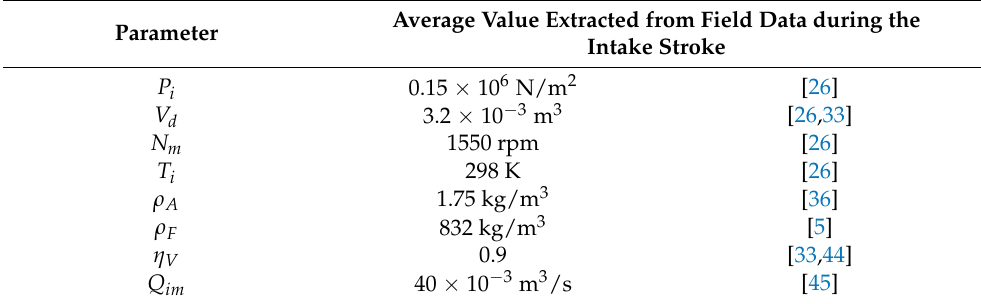
• m AC . Average Value Extracted from Field Data during